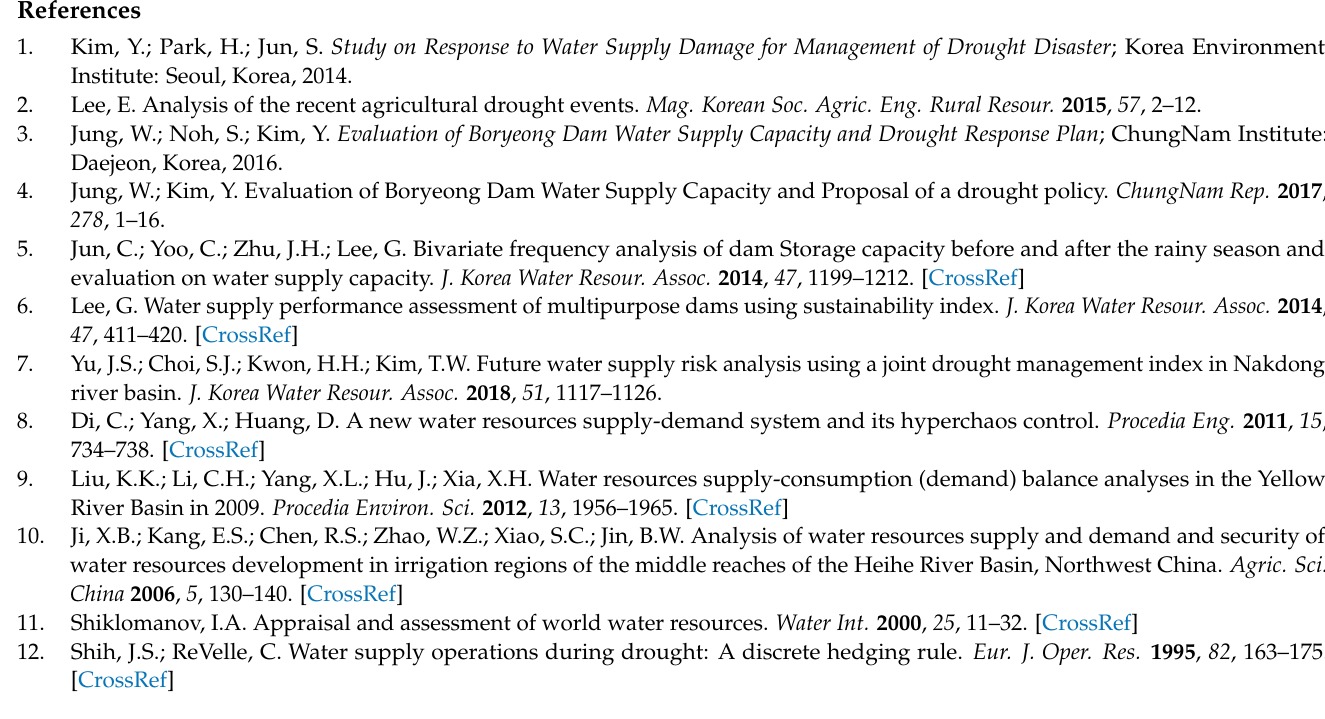
( g ) Namgang Dam; ( h ) Miryang Dam; ( i ) Daecheong Dam; ( j ) Yongdam Dam; ( k ) Seomjingang Dam; ( l ) Juam Dam; ( m ) Juam Controlled Dam; ( n ) Jangheung Dam; ( o ) Buan Dam; ( p ) Boryeong Dam, Figure S2: Estimation results of SI for multipurpose dams in Korea: ( a ) Soyanggang Dam; ( b ) Chungju Dam; ( c ) Heongseong Dam; ( d ) Andong Dam; ( e ) Hapcheon Dam; ( f ) Imha Dam; ( g ) Namgang Dam; ( h ) Miryang Dam; ( i ) Daecheong Dam; ( j ) Yongdam Dam; ( k ) Seomjingang Dam; ( l ) Juam Dam; ( m ) Juam Controlled Dam; ( n ) Jangheung Dam; ( o ) Buan Dam; ( p ) Boryeong Dam, Figure S3: Estimation results of GSI for multipurpose dams in Korea: ( a ) Soyanggang Dam; ( b ) Chungju Dam; ( c ) Heongseong Dam; ( d ) Andong Dam; ( e ) Hapcheon Dam; ( f ) Imha Dam; ( g ) Namgang Dam; ( h ) Miryang Dam; ( i ) Daecheong Dam; ( j ) Yongdam Dam; ( k ) Seomjingang Dam; ( l ) Juam Dam; ( m ) Juam Controlled Dam; ( n ) Jangheung Dam; ( o ) Buan Dam; (p) Boryeong Dam, Figure S4: Estimation results of SI for major river basins in Korea: ( a ) Han River Basin; ( b ) Nakdong River Basin; ( c ) Geum River Basin; ( d ) Seomjin River Basin, Figure S5: Estimation results of SI for the total river basin in